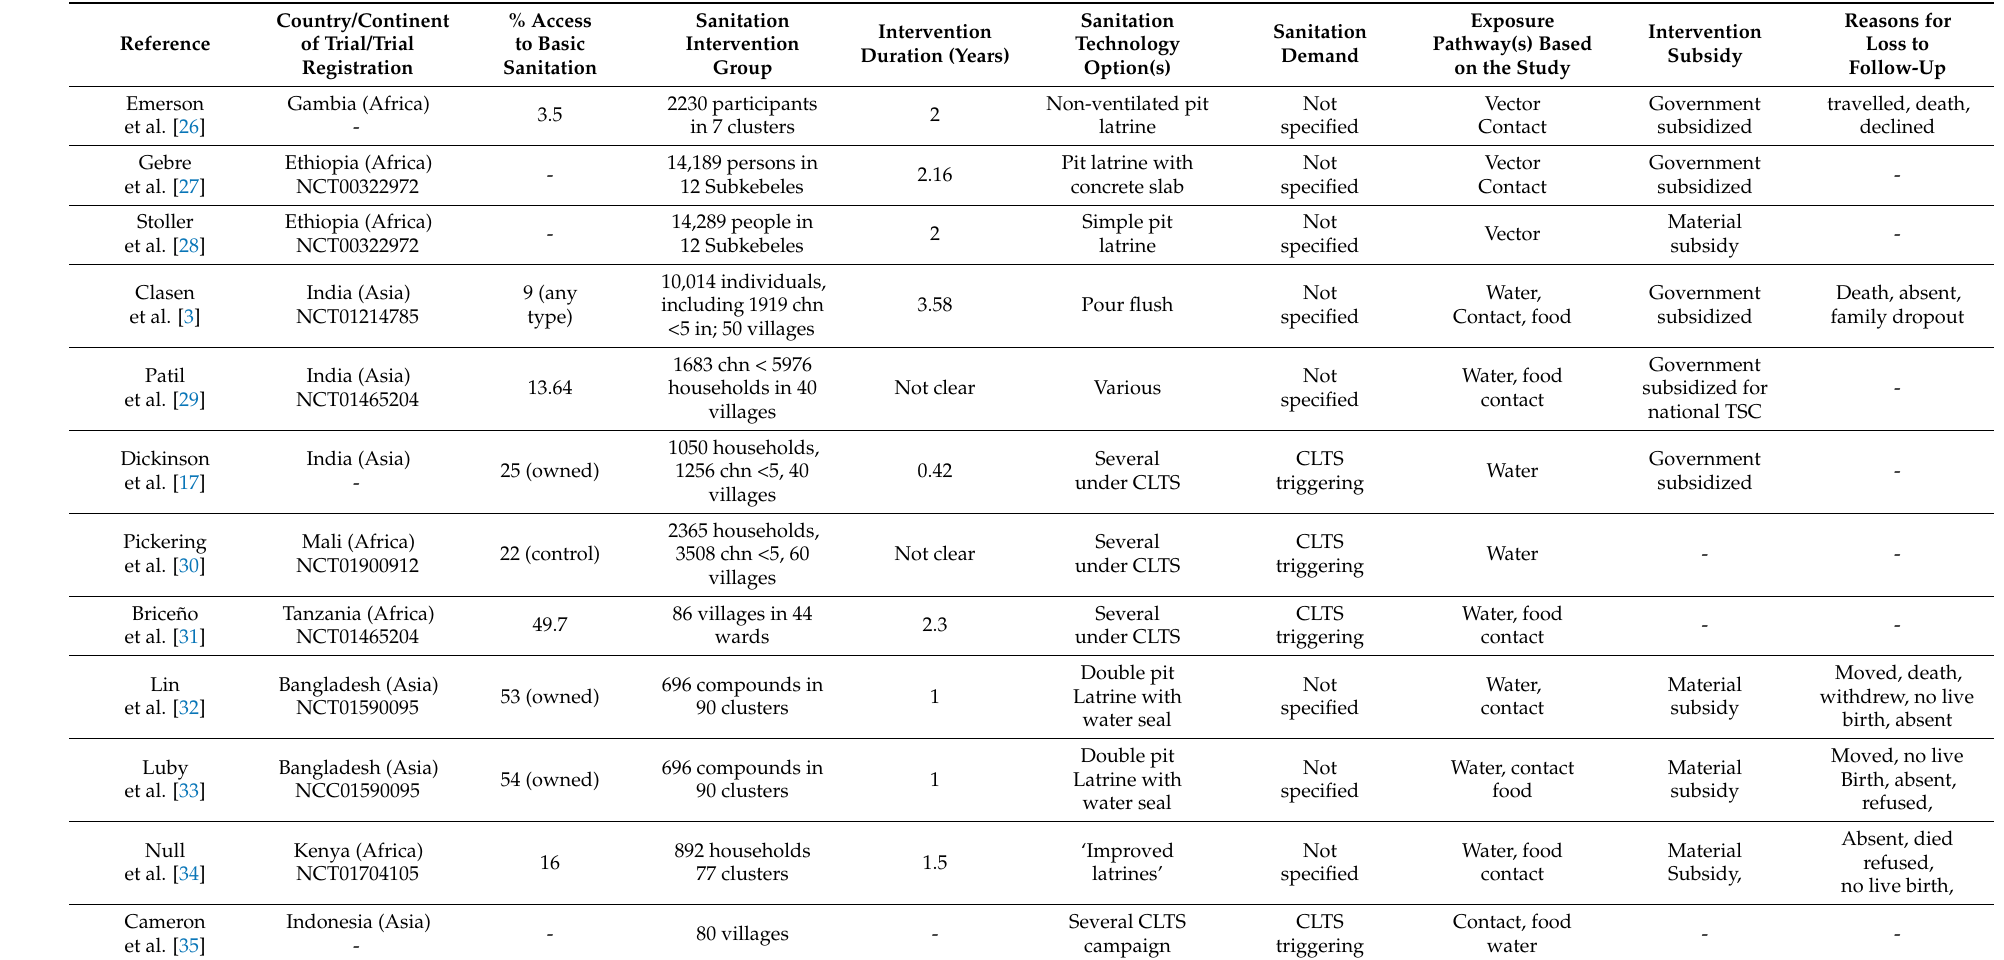
Table 2. Summaries of random controlled trials included for the